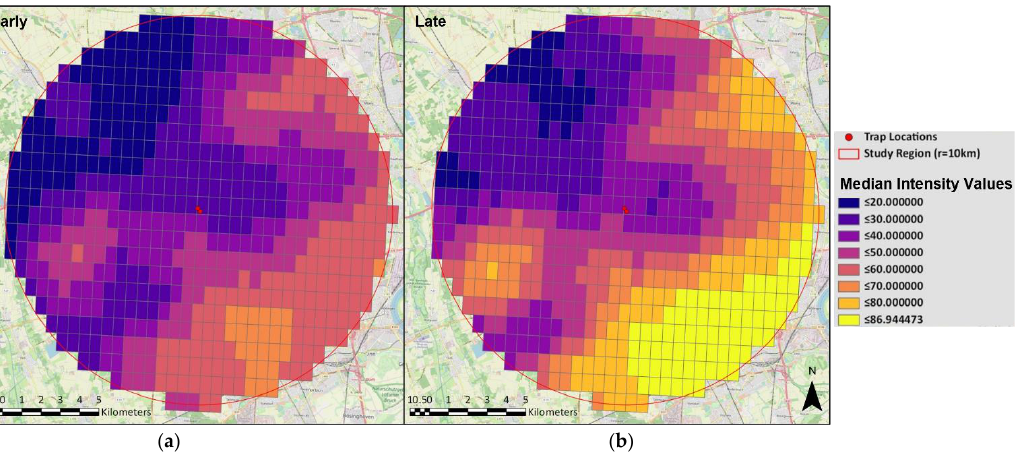
Figure 6. Median nightlight intensity from the early time period ( a , 1992 – 1999) and late time period ( b , 2003 – 2010).